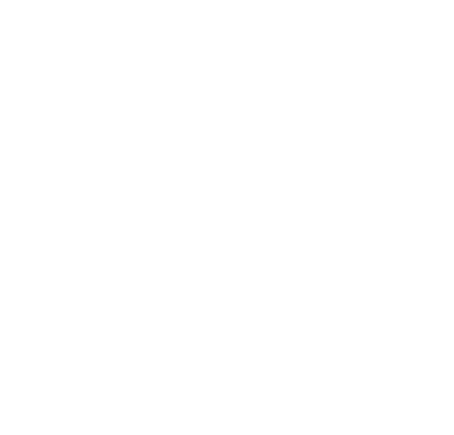
Figure 4. The adaptive natural density partitioning (AdNDP) bonding pattern for B 3 Al 4+ (GM). ON is the occupation number.